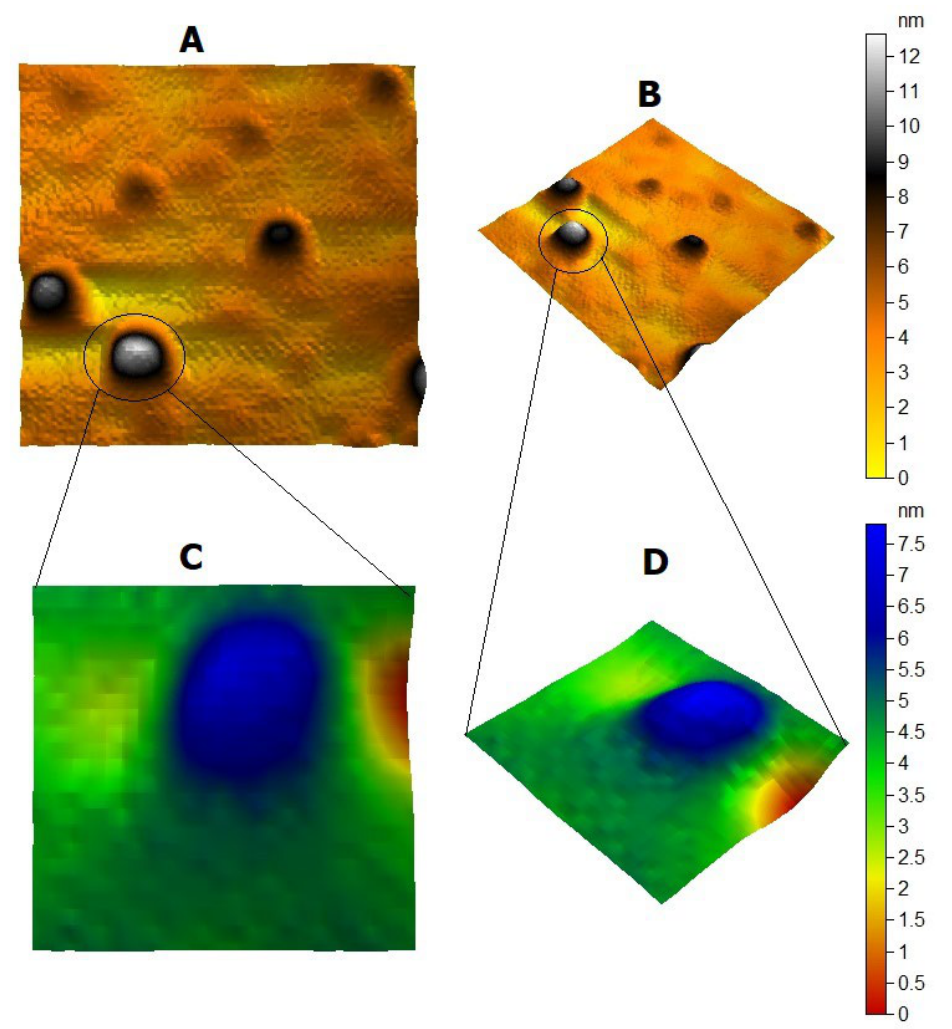
Figure 2. AFM image of colloidal silver nanoparticles. ( A ) 2D-view AFM image of 200 nm × 200 nm size. ( B ) 3D-view AFM image of 200 nm × 200 nm size. ( C ) 2D-view AFM image of 100 nm × 100 nm size. ( D ) 3D-view AFM image of 100 nm × 100 nm size.